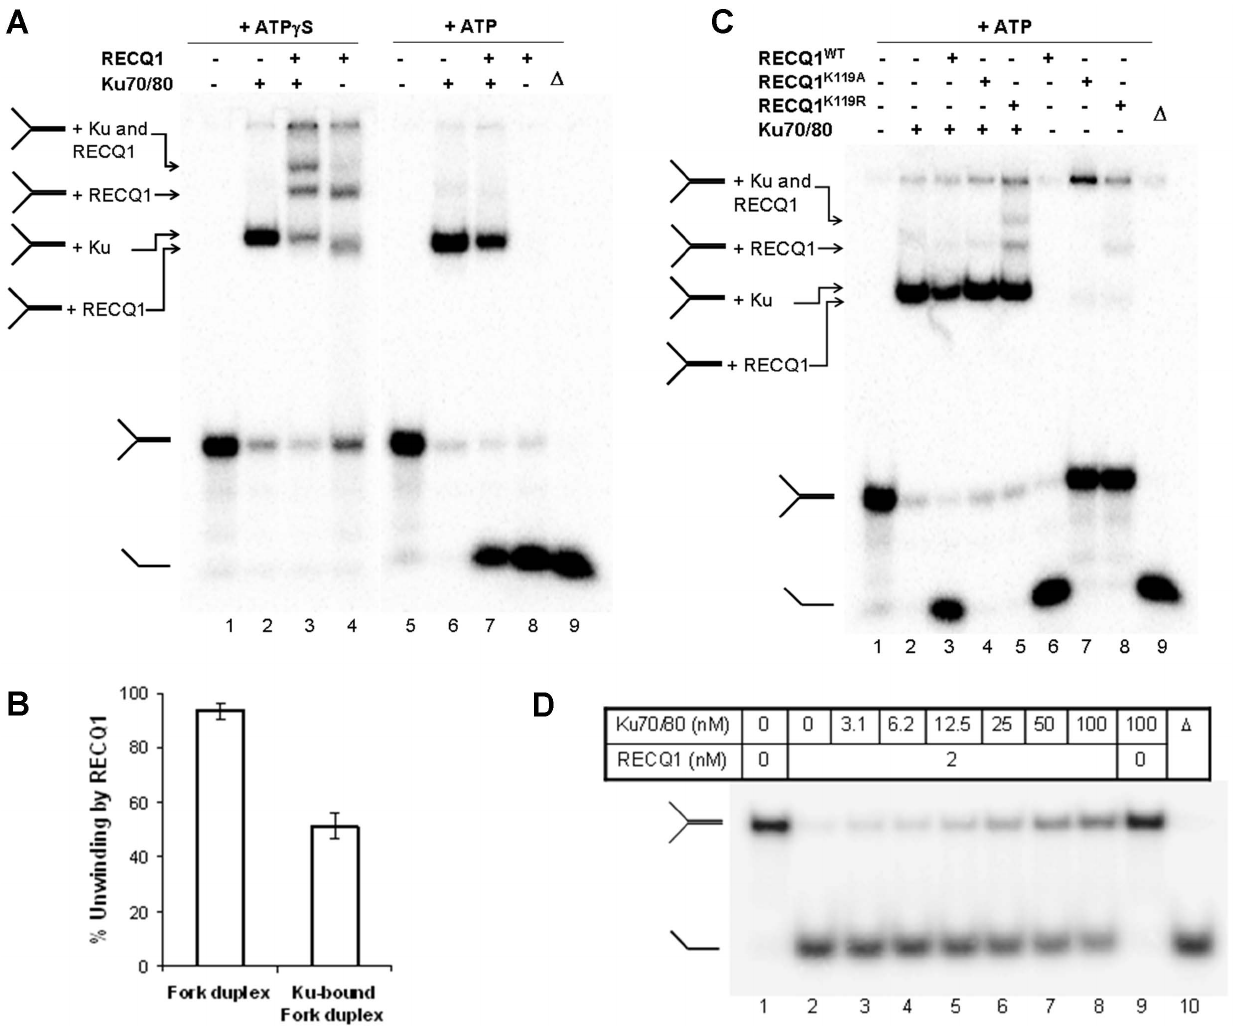
Figure 3. RECQ1 helicase binds and unwinds a Ku-bound forked duplex DNA substrate. A. RECQ1 binds and unwinds Ku-bound fork duplex. Ku70/80 (12.5 nM), RECQ1 (17.3 nM), or both were incubated with radiolabeled fork duplex (0.5 nM) in DNA binding buffer containing ATP c S or ATP (2 mm) as described in materials and methods. The protein-DNA complexes were then resolved on native 5% polyacrylamide gels. Radiolabeled bands were detected by PhosphorImager and a typical gel of resolved RECQ1/Ku70/80-fork duplex mixture is shown. Ku-DNA, RECQ1- DNA and RECQ1-Ku-DNA complexes are indicated based on their gel mobility shift. When binding reaction mixtures contained ATP, fork duplex, either alone or in complex with Ku70/80, was unwound by RECQ1 helicase resulting in the appearance of a faster migrating single stranded oligonucleotide as indicated. B. Quantitative comparison of RECQ1 unwinding of fork duplex or a Ku70/80-bound fork duplex assayed under DNA binding conditions in the presence of ATP (2 mM). The results shown are the average of at least three independent experiments, with SD indicated by error bars. C. Intrinsic ATPase activity of RECQ1 is essential for unwinding of Ku-bound fork duplex. Unwinding of Ku-bound fork duplex mediated by the RECQ1 K119A , RECQ1 K119R or wild-type RECQ1 WT (each 17.3 nM) was assayed under DNA-binding conditions in the presence of ATP (2 mm). D. RECQ1 helicase activity is inhibited at several fold molar excess of Ku70/80. Helicase reactions containing fork duplex DNA substrate (0.5 nM) and the specified concentrations of Ku70/80 in the presence or absence of RECQ1 (2 nM) were incubated at 37 u C for 15 min under standard helicase assay conditions as described in materials and methods. Phosphorimage of a typical gel is shown. D , heat-denatured DNA substrate control.